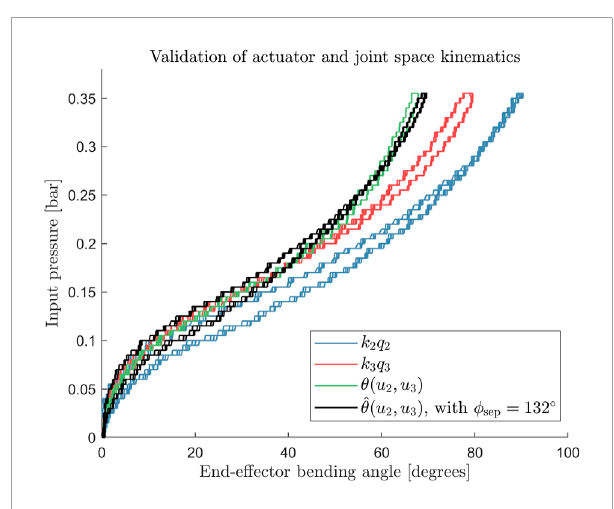
The means of hysteresis h